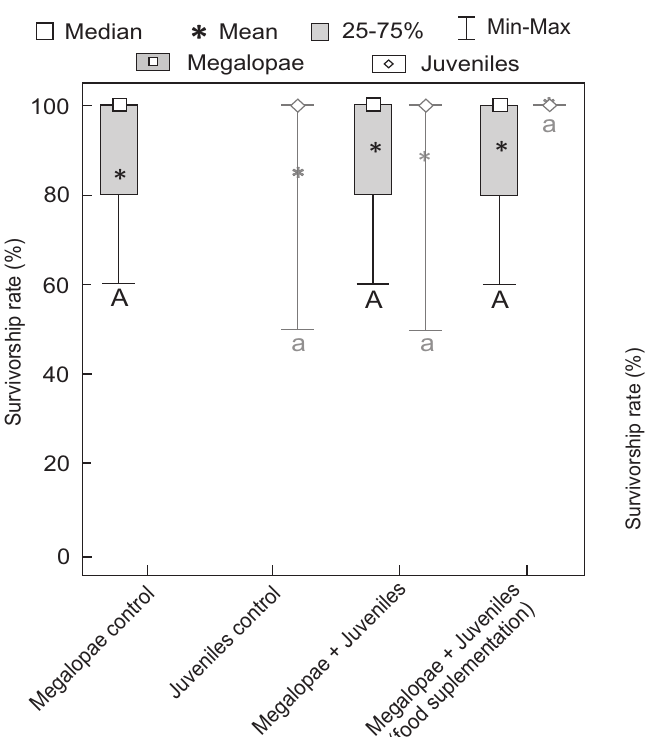
Figure 3. Survivorship rates of U. cordatus in the megalopae and juvenile phase reared separately and together, in the presence or absence of supplementary food. Letters under boxes indicate ho- mogeneous groups according to the statistical